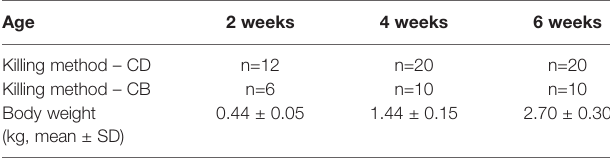
TABLE 2 | Experimental design of Effectiveness and Animal Welfare